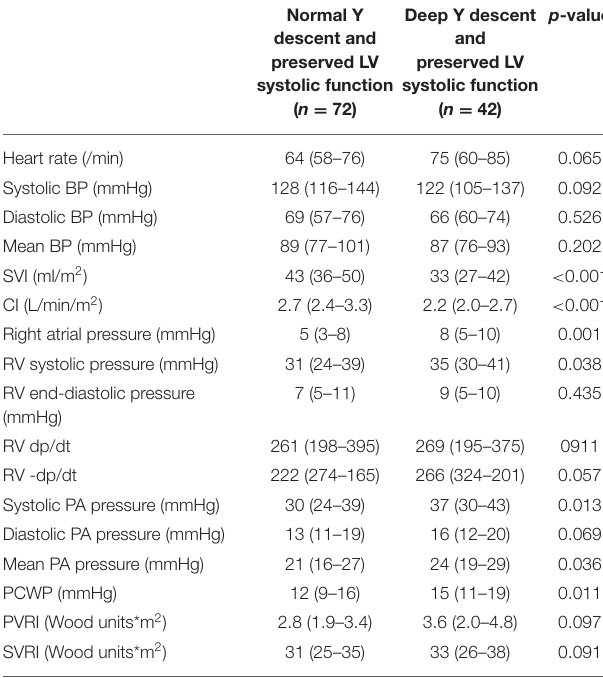
TABLE 1 | Patient characteristics according to right atrial pressure waveform. TABLE 2 | The results of right heart